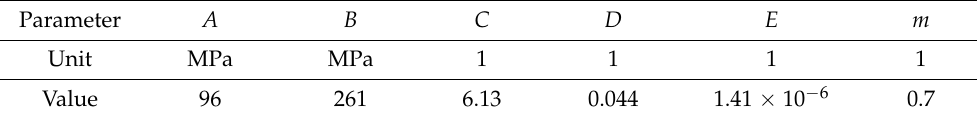
Table 2. Parameters of the SK model for OFHC [70] (